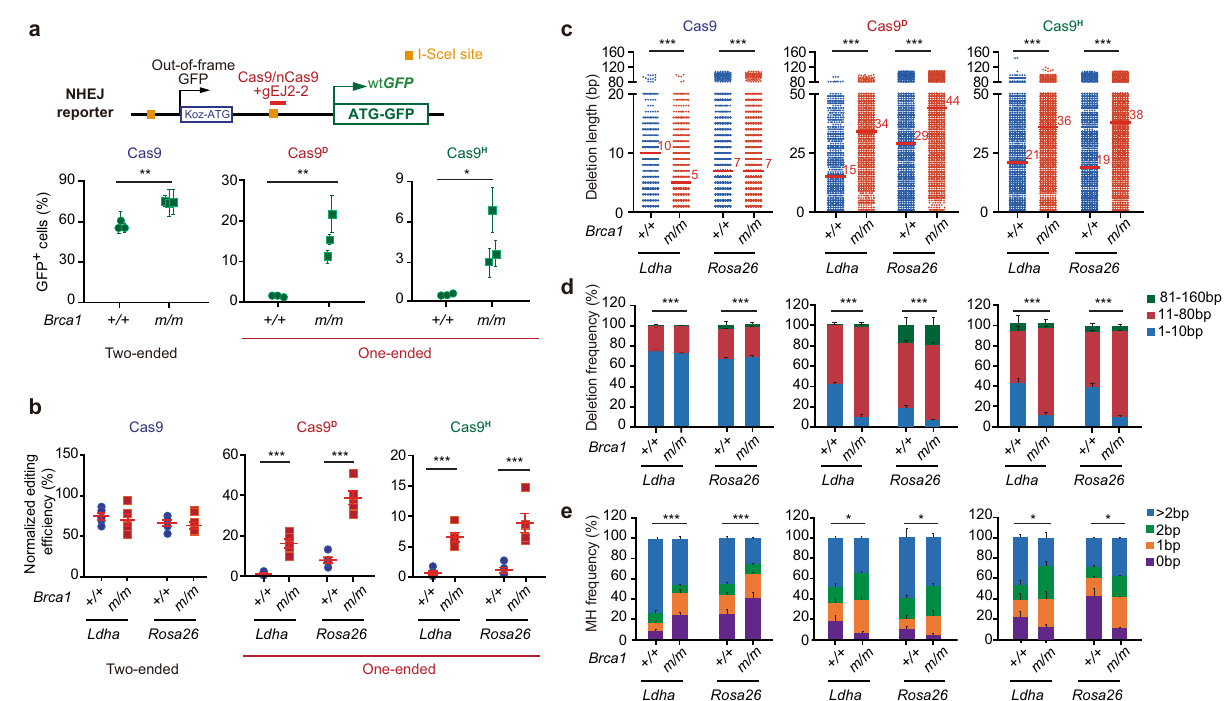
Fig.3| Brca1 de fi ciencystimulatesnick-inducedNHEJwithlongerdeletionsand more MH usage at repair junctions. a Cas9- or nCas9-induced NHEJ in multiple isogenic Brca1 +/+ and Brca1 m/m mESC clones containing an NHEJ reporter indicated on the top. The NHEJ reporter contains a stronger arti fi cial Kozak-ATG translation startsite ‘ Koz-ATG ’ thatcausesproteinsynthesisofout-of-frameGFP.NHEJofCas9- or nCas9-induced breaks in the reporter could generate GFP + cells by GFP reframing. Solid green circles and squares indicate independent clones. b Cas9- or nCas9-induced NHEJ at intron 5 of mouse Ldha and intron 2 of Rosa26 locus in Brca1 +/+ and Brca1 m/m mESC. The NHEJ-mediated editing ef fi ciency is calculated as